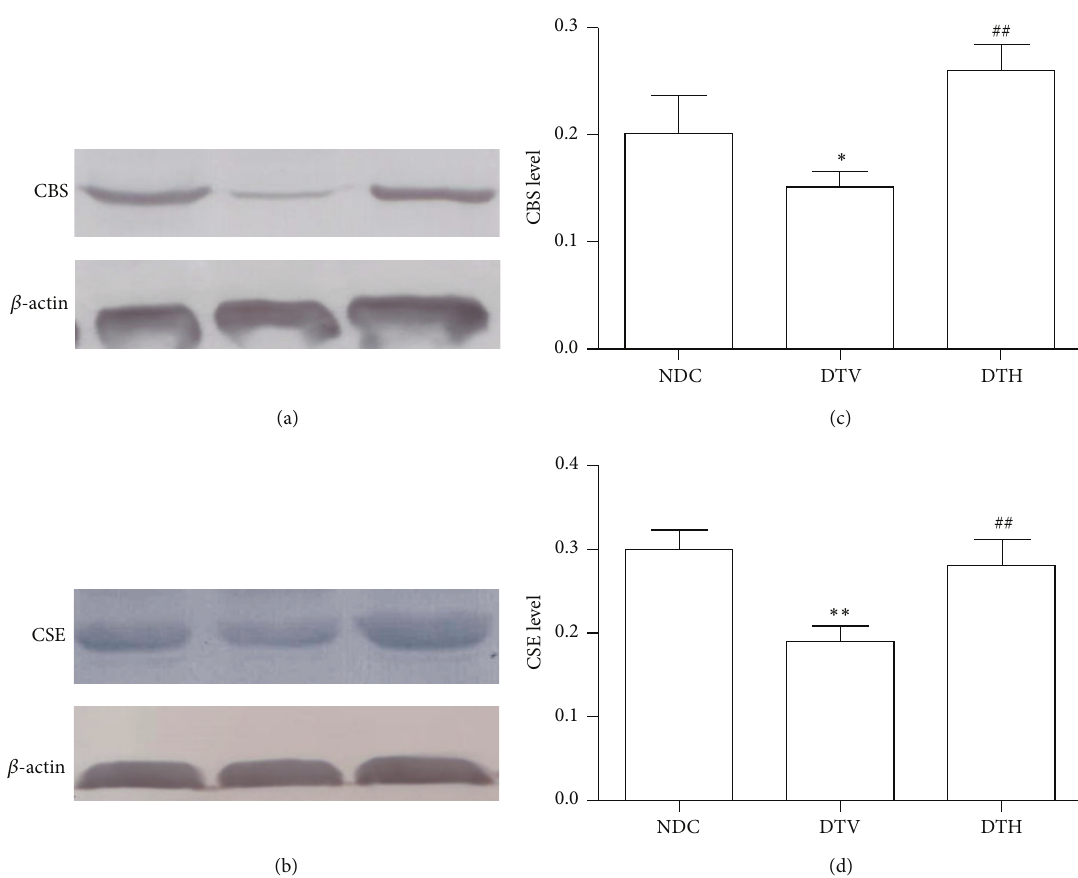
Figure 5: HO-1 improved the expression of hydrogen sulfide synthase. HO-1 increased expressions and relative levels of CBS ((a) and (c)) and CSE ((b) and (d)) ( ∗ 𝑃 < 0.05 versus NDC; ∗∗ 𝑃 < 0.01 versus NDC; ## 𝑃 < 0.01 versus